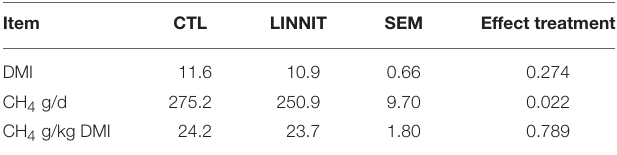
TABLE 1 | Dry matter intake and methane emissions from bulls fed control (CTL) diet ( n = 8) or diet supplemented with a combination of linseed plus nitrate (LINNIT) ( n =